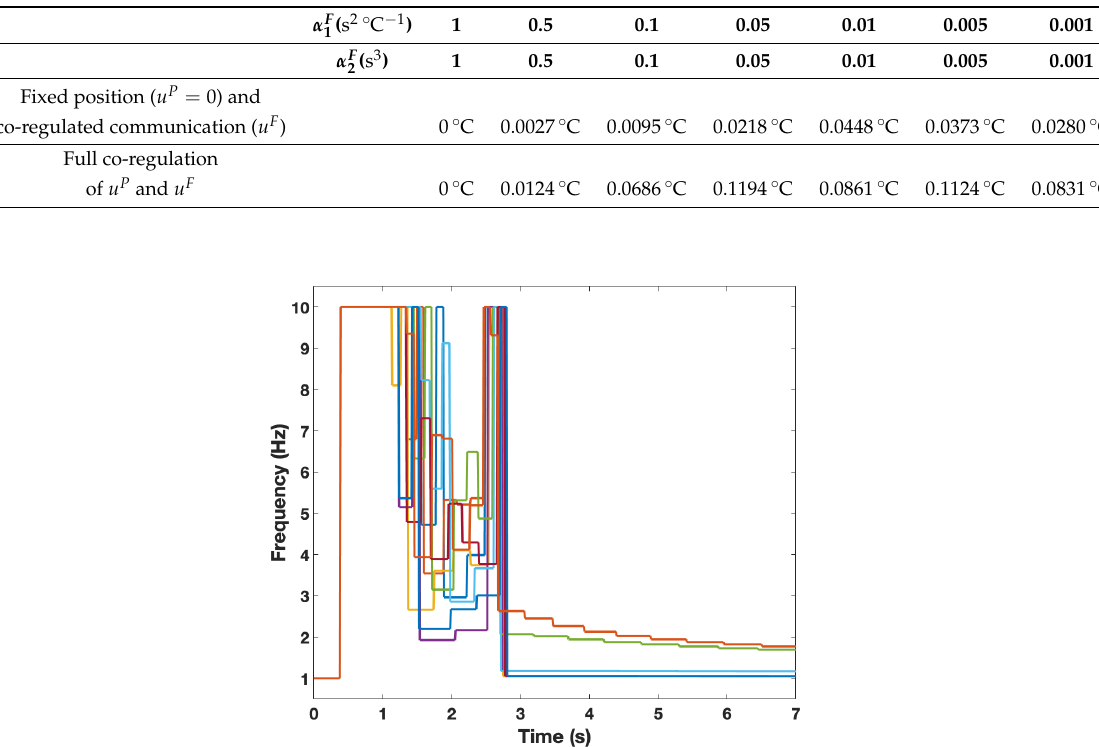
Figure 4. Communication frequency at small alpha parameters, α 1 = 0.05 and α 2 =